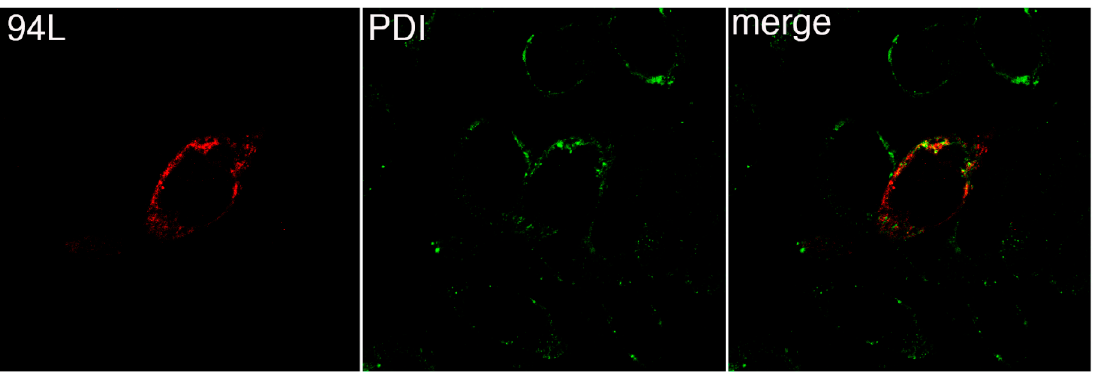
Figure 3. 94L localizes to the Endoplasmic Reticulum. BGMK cells were transfected with pcDNA3-94L-myc. Forty-eight hours post-transfection, the cells were fixed and indirect immunofluorescence was performed using mouse anti-myc antibodies (red) and rabbit anti-PDI antibodies (green). Images were captured at 100× magnification using a confocal microscope.